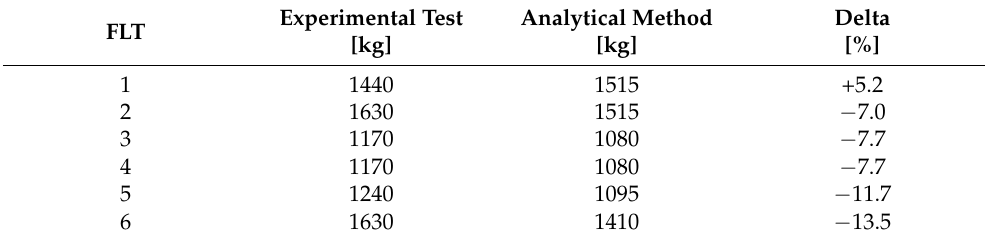
Table 3. Comparison between experimental tests and analytical procedure for clamp for